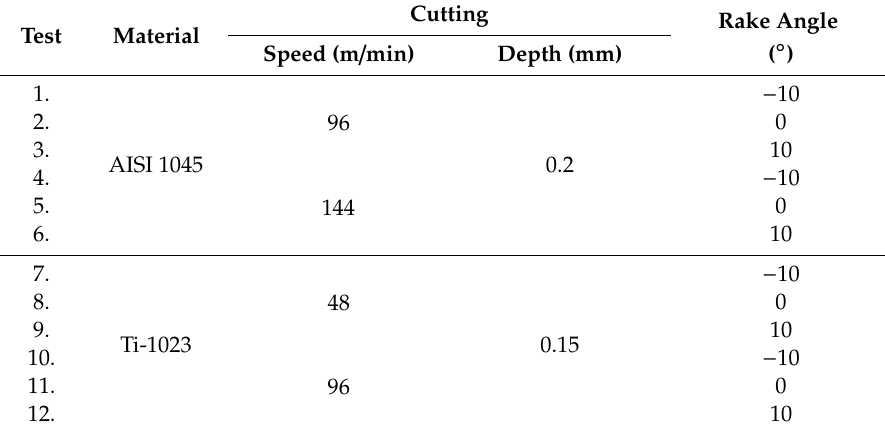
Table 4. Cutting parameters and tool orthogonal rake angles in the experimental and simulative cutting tests.